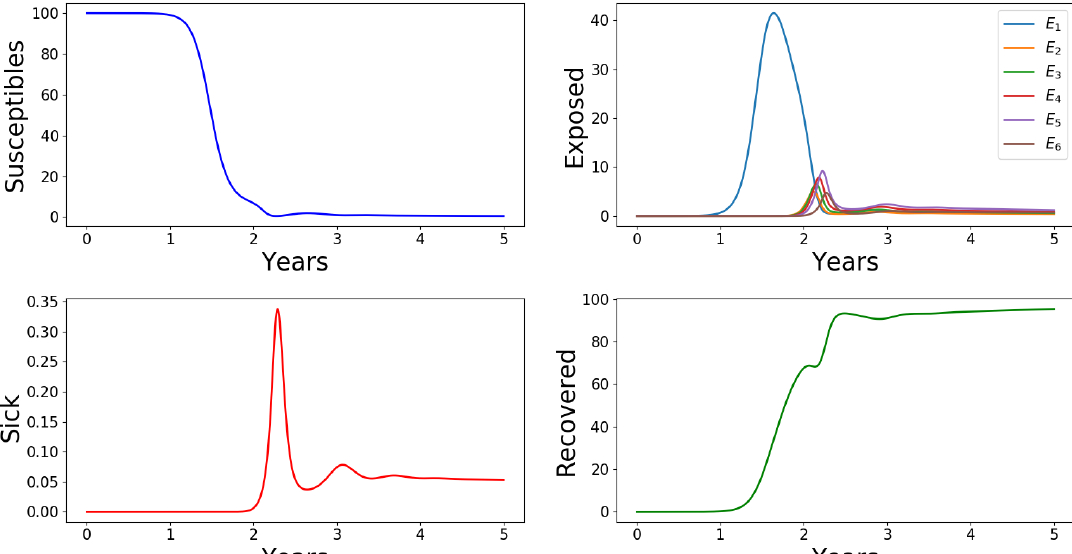
Figure 4. Profiles for all the variables of Model (1)–(6). The horizontal axes scale the time in days and the vertical axes scale the population sizes in percentages. The first infectious case arises in the population E 2 and is able to spread to other infectious classes so that the disease is maintained in the population. ‘Sick’ humans are those of the class I who show clinical signs of the disease. ORS = 1 :